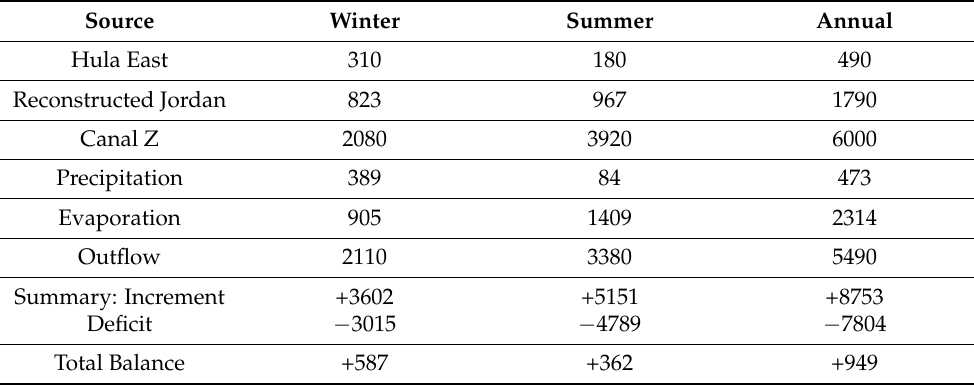
Figure 17. Linear regression (CI 95%) between the TP loading (t/y) of Jordan River in relation to two headwaters, Hazbani and Banias.